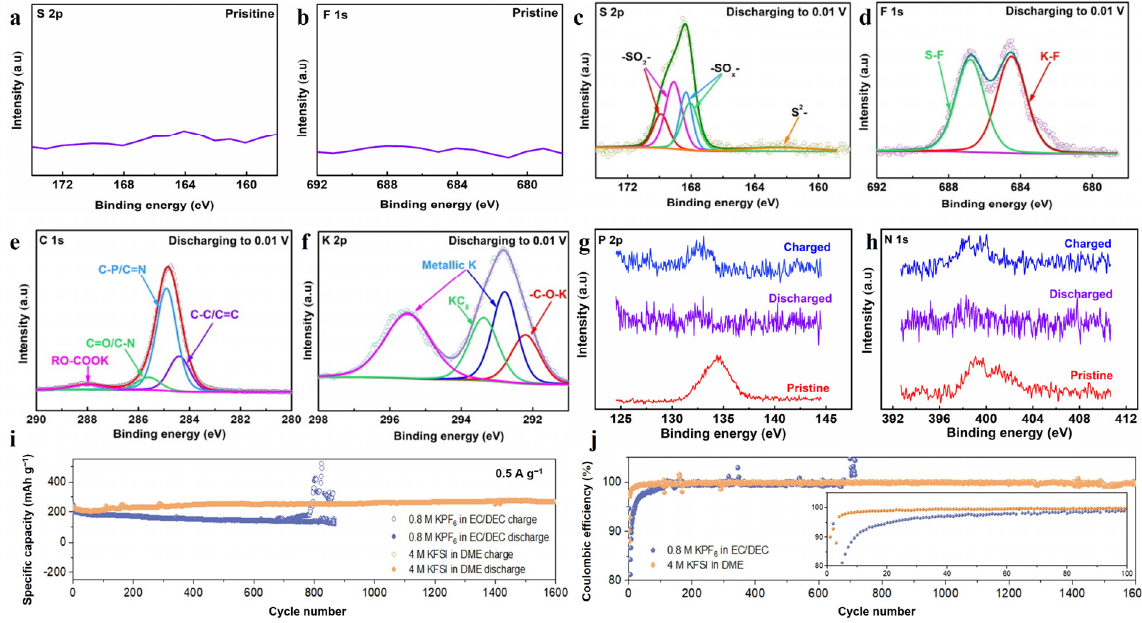
Figure 5. XPS ( a ) S 2p and ( b ) F 1s spectra of PN-CNC at pristine state; high-resolution XPS spectra of ( c ) S 2p, ( d ) F 1s, ( e ) C 1s and ( f ) K 2p spectra for PN-CNC after discharging to 0.01 V (the cells are cycled at 0.1 A g − 1 ); ex situ XPS ( g ) P 2p and ( h ) N 1s spectra of PN-CNC [82]. Copyright 2022, Elsevier. ( i ) Cyclic performances at 0.5 A g − 1 and ( j ) the corresponding coulombic e ffi ciency plots in di ff erent electrolytes of M-NC [83]. Copyright 2022, Wiley-VCH.